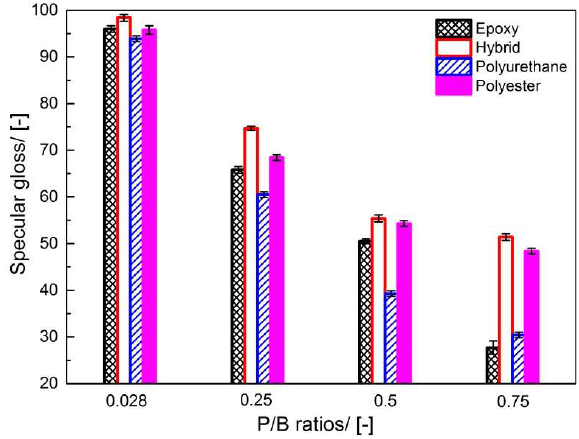
Figure 5. Specular gloss of formulations with different resins and P/Bs.